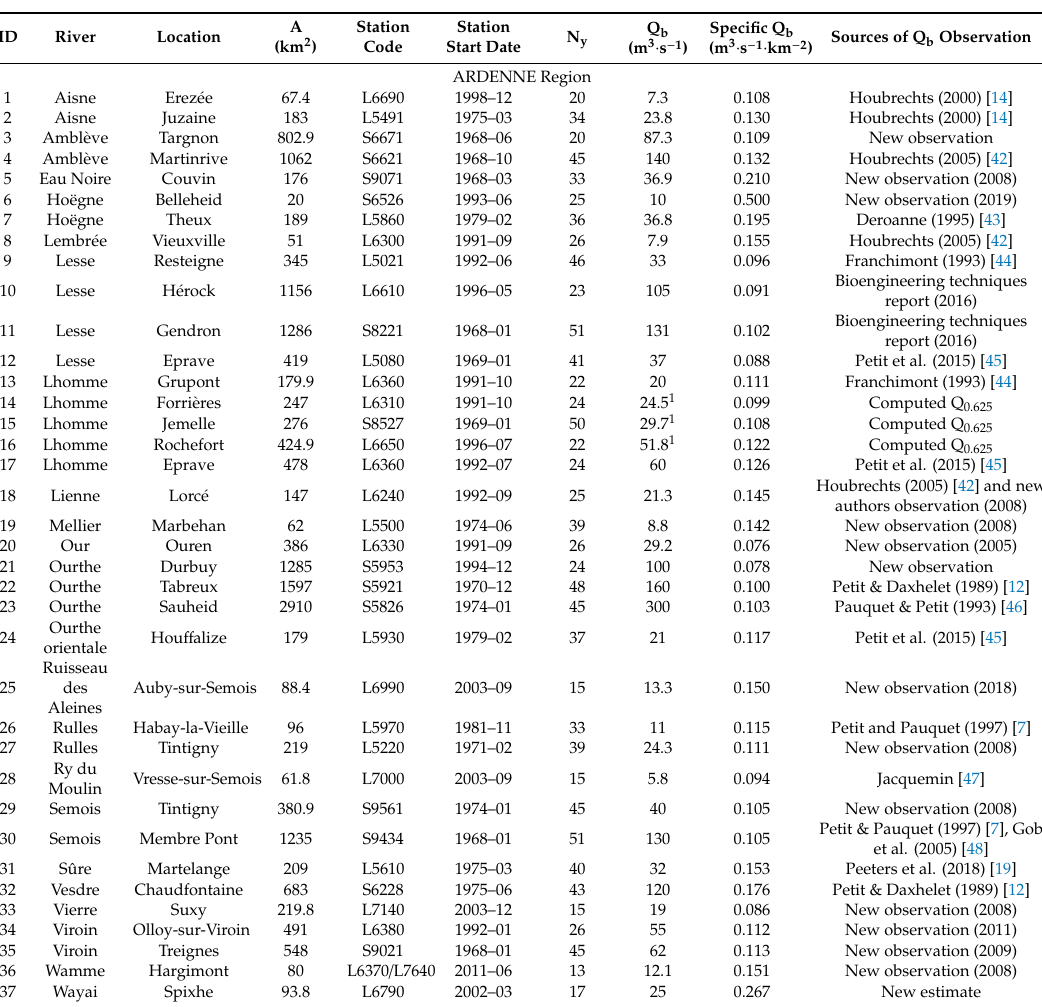
Table 1. Hydrological parameters of the studied